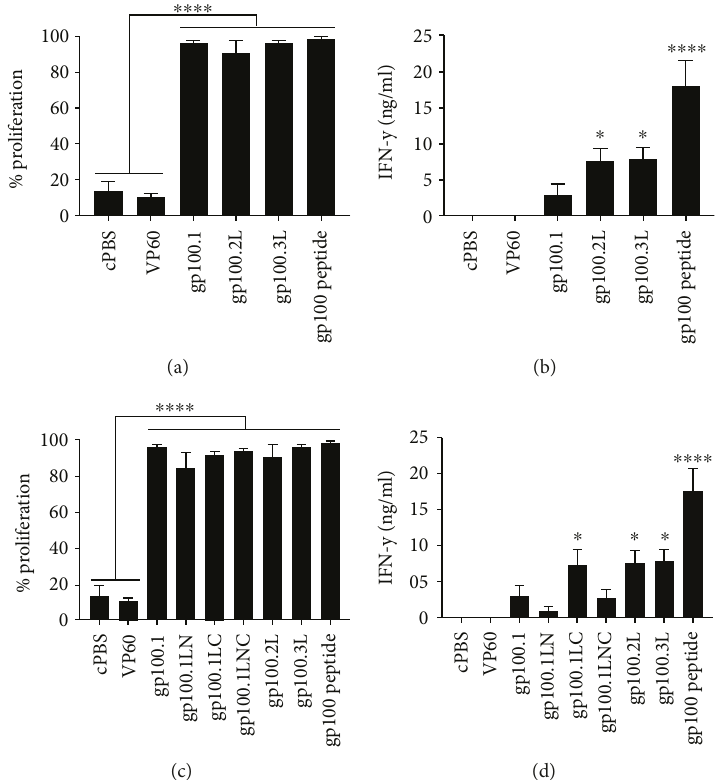
Figure 2: In vitro T-cell activation by gp100 VLPs. BMDC were pulsed with 10 μ g/ml VLP or gp100 peptide at a molar equivalent to gp100 in gp100.2L VLP. CD8+ T-cells from Pmel mice were cocultured with activated BMDC for 72 h. (a, c) Proliferation of T-cell in coculture, measured by fl ow cytometry. (b, d) Supernatants from cocultures were harvested and IFN- γ measured by ELISA. Graphs show the mean of three independent experiments ± SEM. Statistical signi fi cance was determined by one-way ANOVA with Tukey ’ s post hoc tests, ∗∗∗∗ p < 0 0001 , ∗ p < 0 05 . Statistical signi fi cance displayed is the comparison between untreated cells (cPBS and VP60) and treated